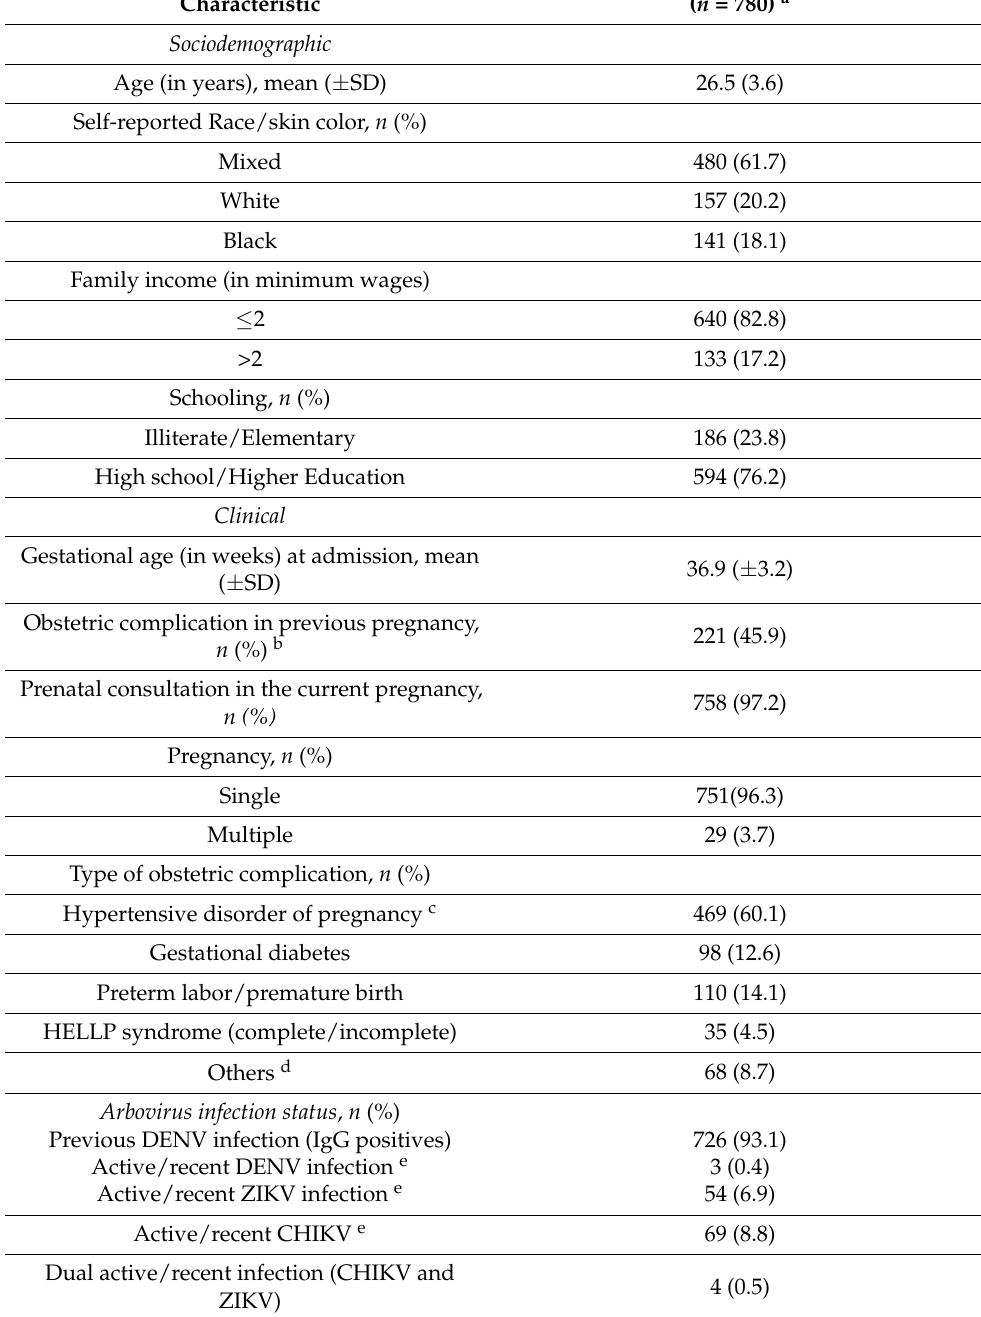
Table 1. Sociodemographic and clinical characteristics and arbovirus immune status of the study